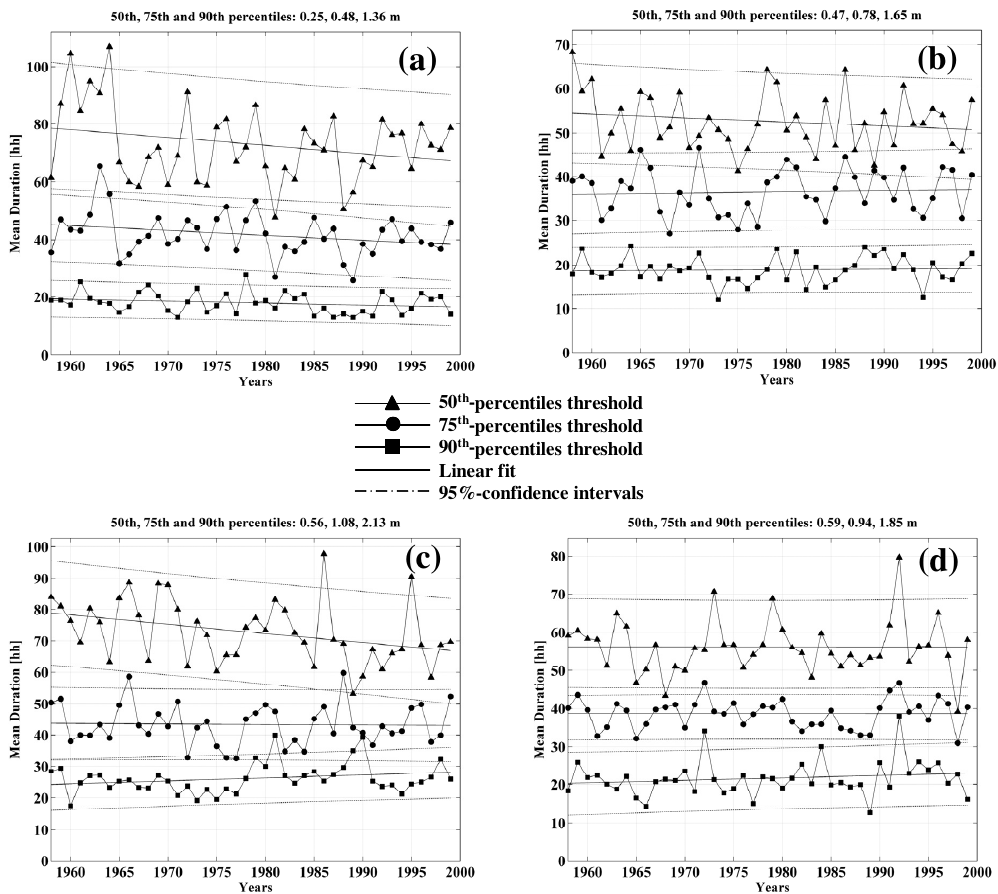
Figure 7. From panel (a) to (d), in the same order as for Figure 3A, are shown the annual averaged H s durations over three thresholds: the 50th, 75th and the 90th percentiles of the (ascending) ordered ERA-40 UNILE dataset. A linear fit is also shown.